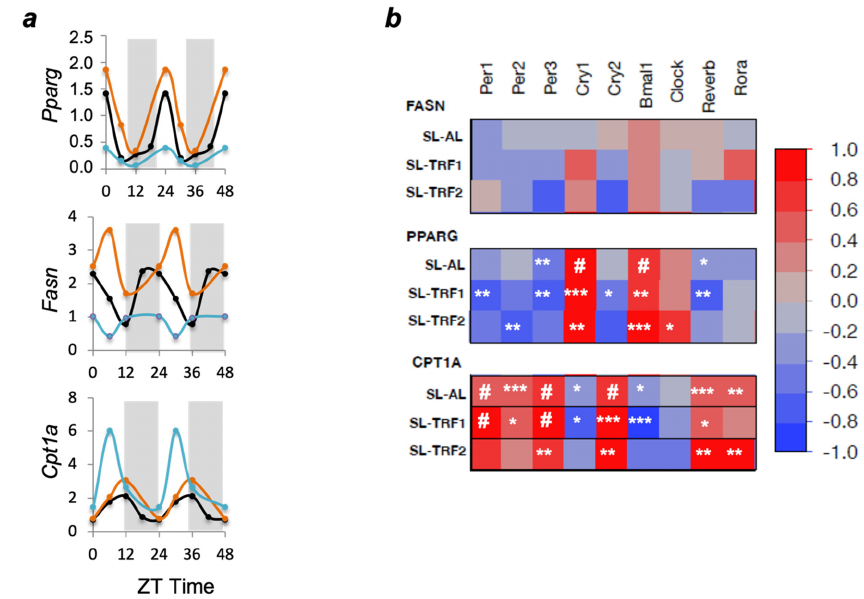
Figure 5. The dietary interventions modify the correlations between the clock genes and Pparg-Cpt1a . ( a ) mRNA expression levels of lipogenic genes ( Fasn , Pparg ) and FFA oxidation gene ( Cpt1a ) during a 24-h in SL-AL (black) ( n ≥ 10), SL-TRF1 (orange) ( n ≥ 5) and SL-TRF2 (blue) mice ( n ≥ 5) at the end of the intervention. Data are presented as a “double-plot”, in which the 24-h expression is duplicated in order to better visualize the cyclic behavior of the genes. ( b ) Correlogram. The heat map indicates the Pearson correlation coefficients between the clock genes (columns) and lipid genes (rows). The red color designates positive correlations, whereas the blue color designates the negative correlations. The correlations that reached statistical significance are indicated as follows: * p < 0.05, ** p < 0.01, *** p < 0.001, # p < 0.0001, versus the SL-AL group.